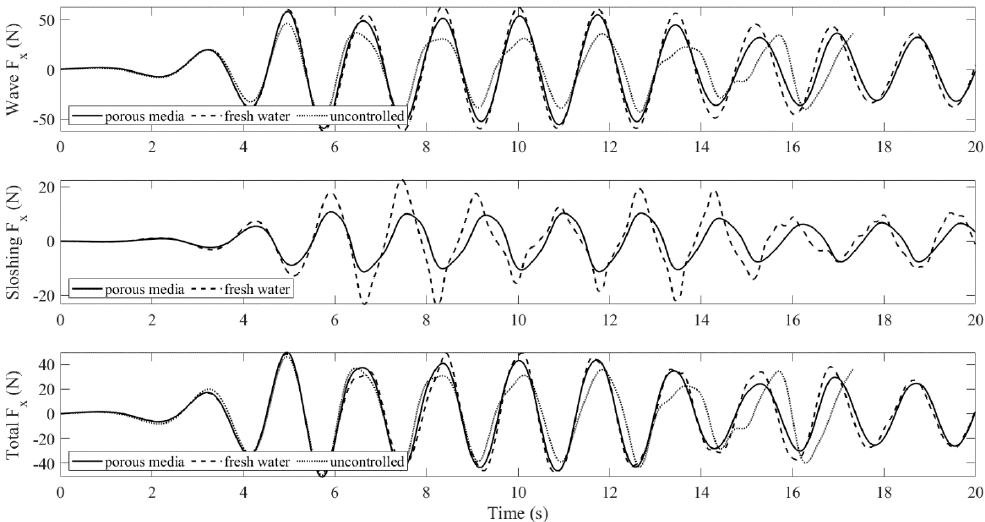
Figure 24. The horizontal forces act on the controlled and uncontrolled floating bodies for the large- wave case. The body motions and the resultant forces along the vertical direction are shown in Figures 25 and 26, respectively. The mean values of the steady-state displacement were different for the controlled and uncontrolled cases because their total weights were differ- ent. The uncontrolled body was lighter, so it had a larger initial acceleration. As their tran- sient response vanished, they oscillated in the same way but had different equilibrium points. This implies that the sloshing fluid did not change the heave motion of the body. Besides, the difference between the vertical sloshing forces from the tanks with and with- out porous media equaled their difference in water weight. The porous media did not affect the vertical sloshing force.